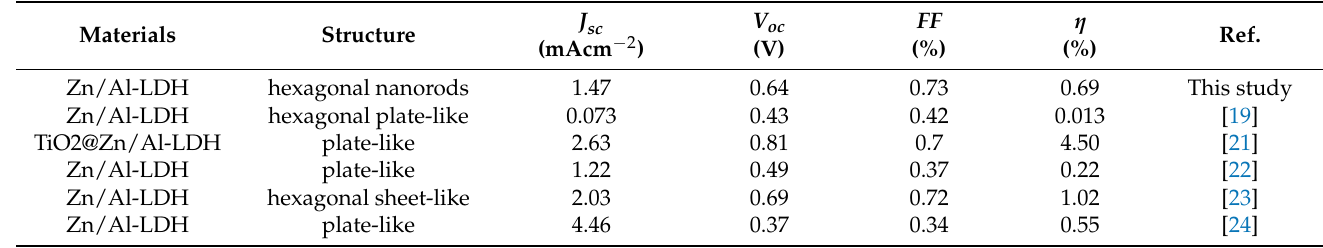
Table 3. J-V characteristics as compared to other studies.